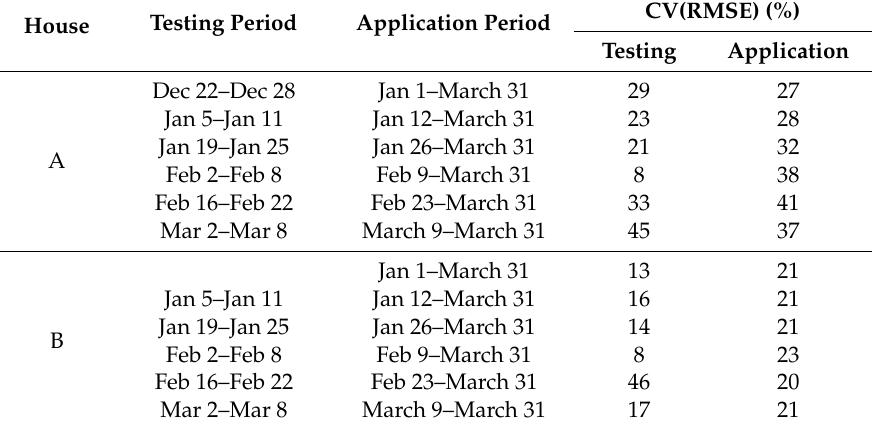
Table 5. CV(RMSE) values over the testing and application periods with the augmented window